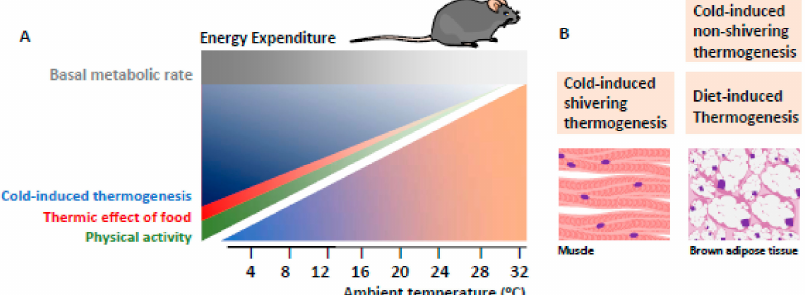
Figure 2. Cellular energy used in adaptive thermogenesis. ( A ) The total energy expenditure of the mouse can be divided into four components: basal metabolic rate, physical activity (green), the thermal e ff ect of food (red) and cold-induced thermogenesis (blue). At room temperature (20–22 ◦ C) more than one third of the total energy expenditure is cold-induced thermogenesis, which is required to maintain body temperature. ( B ) The energy used for cold-induced thermogenesis is mainly produced by skeletal muscle shivering and BAT